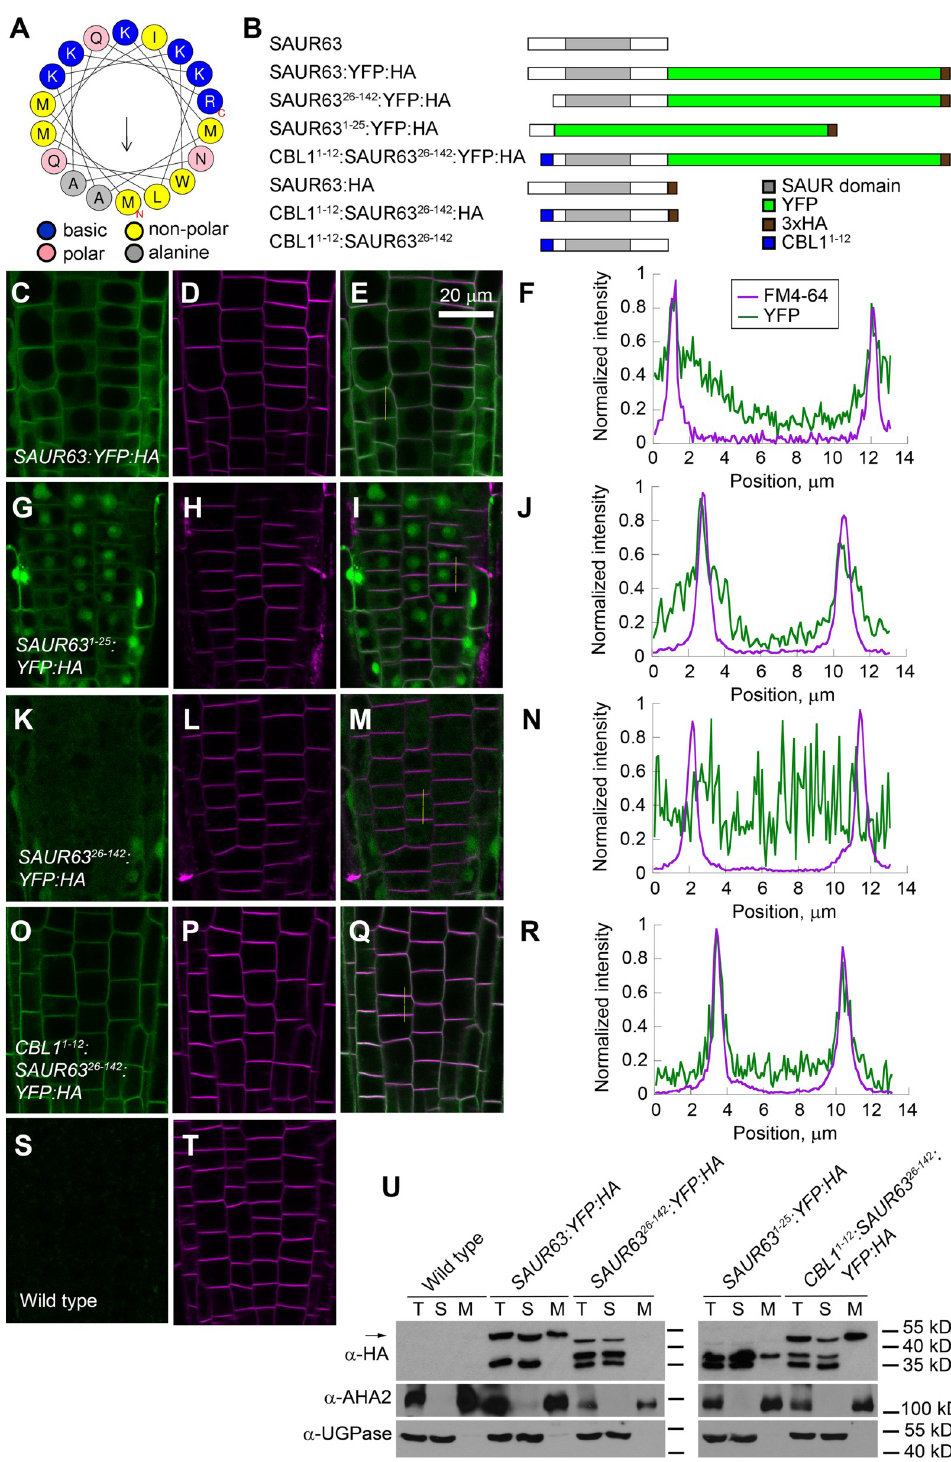
Fig 3. Effects of N-terminal domain manipulations on SAUR63 fusion protein localization. A) Helical wheel projection of SAUR63 N-terminal 18 amino acids. Arrow indicates direction of hydrophobic moment. B) Diagram of SAUR63 and various fusion proteins overexpressed in this study. Gray bar, SAUR domain; Green, YFP; Brown, HA epitope tag; Blue, Myristoylation and palmitoylation signal from CBL1. C-R) Visualization of SAUR63:YFP:HA fusion proteins in root meristem epidermal cells. C-F) SAUR63:YFP:HA. G-J) SAUR63 1-25 :YFP:HA. K-N) SAUR63 26-142 :YFP: